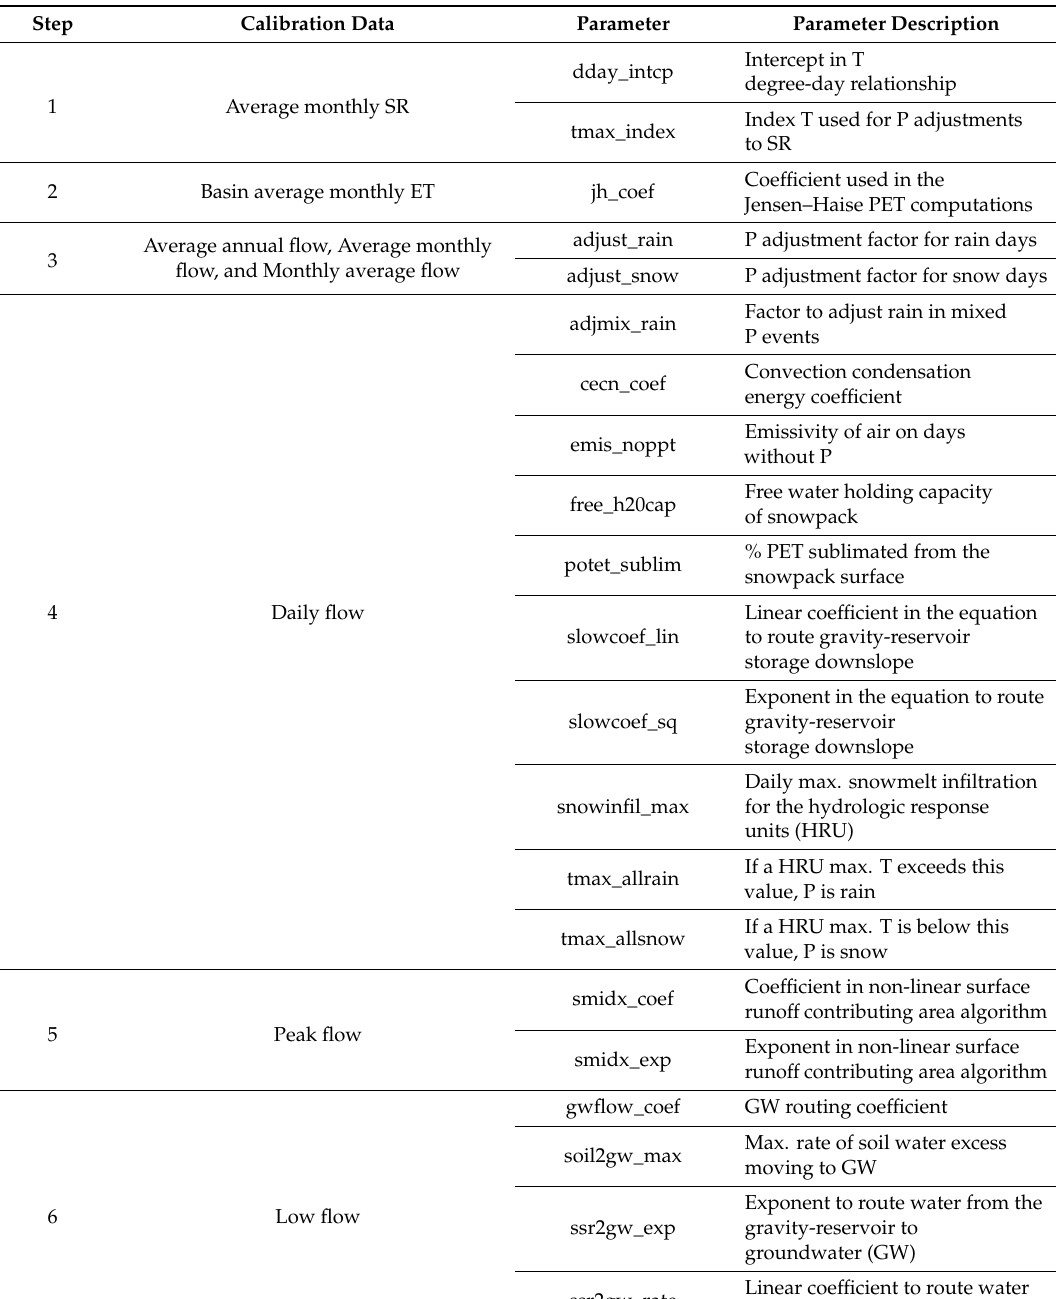
Table 2. The 21 sensitive parameters listed by each step of the LUCA tool for the PRMS hydrologic model. The final sensitive parameter values of reference watershed hydrologic model parameterization were transferred to complete the study watershed